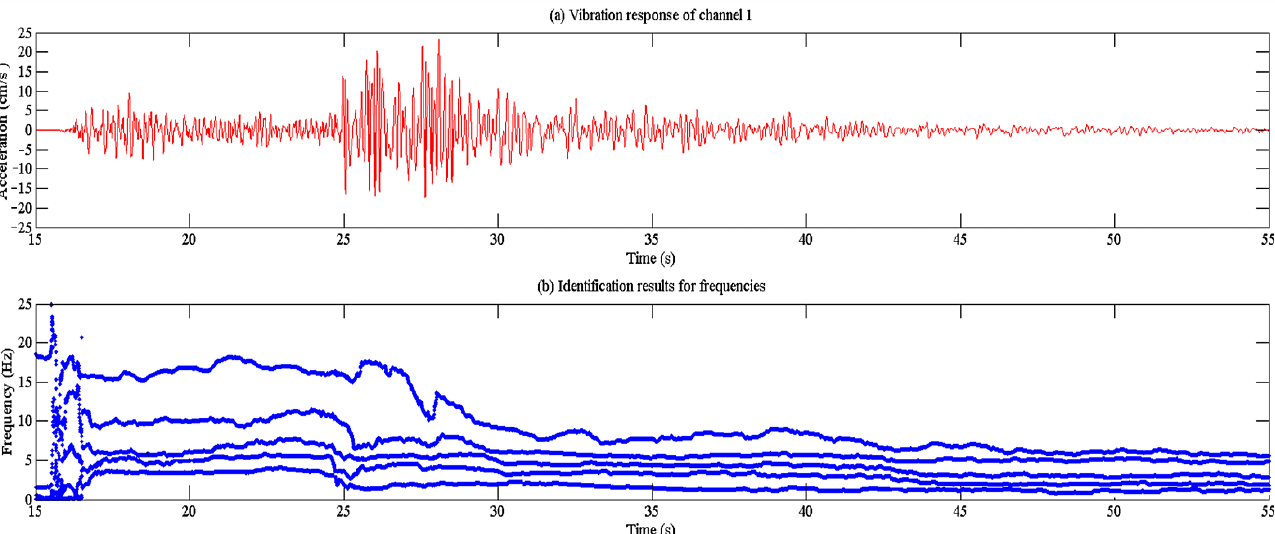
Figure 11. Time-variant frequency identification results of seismic records obtained by Tarinejad and Alves: ( a ) 1994 Northridge earthquake; ( b ) 2001 San Fernando earthquake.